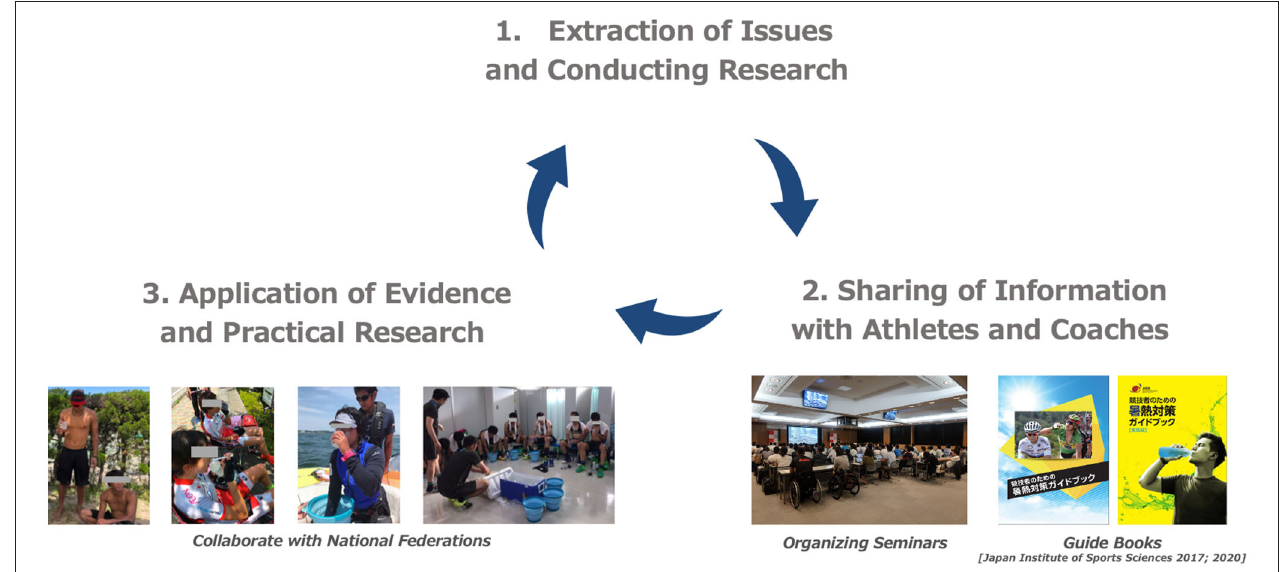
FIGURE 1 | The Heat Countermeasures Project approach for the Tokyo 2020 games.